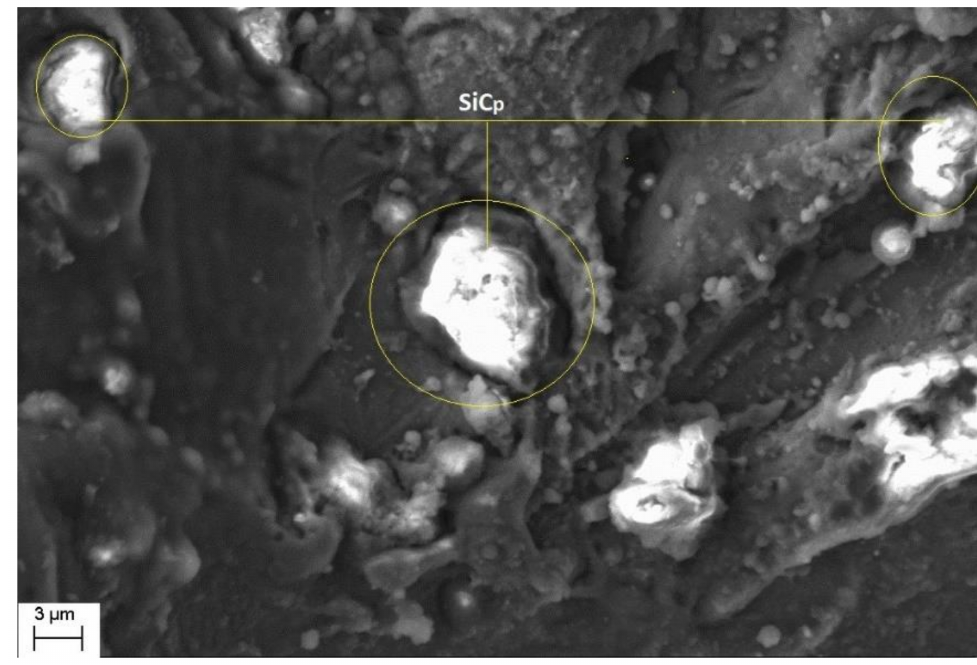
Figure 10. The intact SiC p on the cut surface.